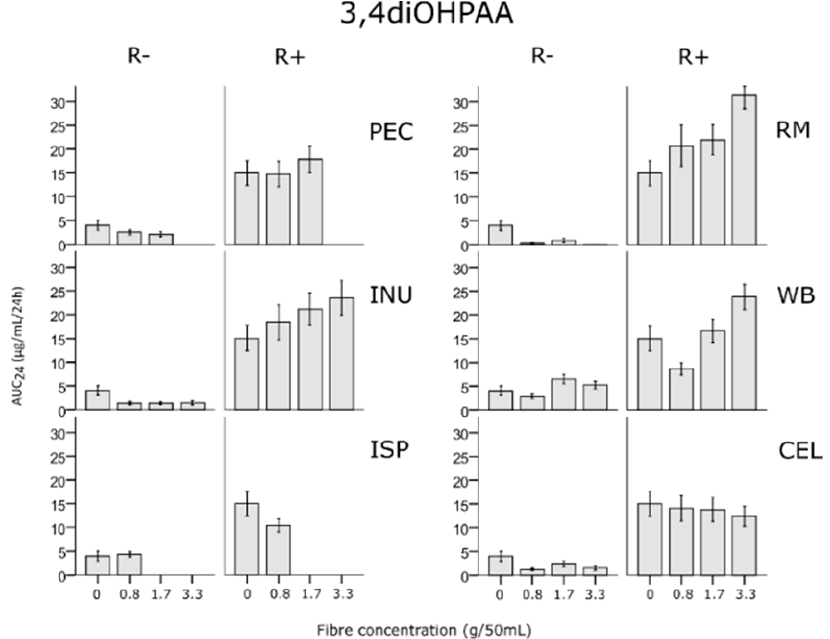
Figure 4. Area under the curve over 24 h of main metabolite 3,4diOHPAA in fermentations with rutin added (R+, 20 µg/mL) and without rutin (R-) as influenced by presence of fibre at four concentrations (0, 0.8, 1.7 and 3.3 g/50 mL); INU, inulin, PEC, pectin, ISP, psyllium, RM, pyrodextrin, WB, wheat bran, CEL, cellulose; means ± S.E.M.